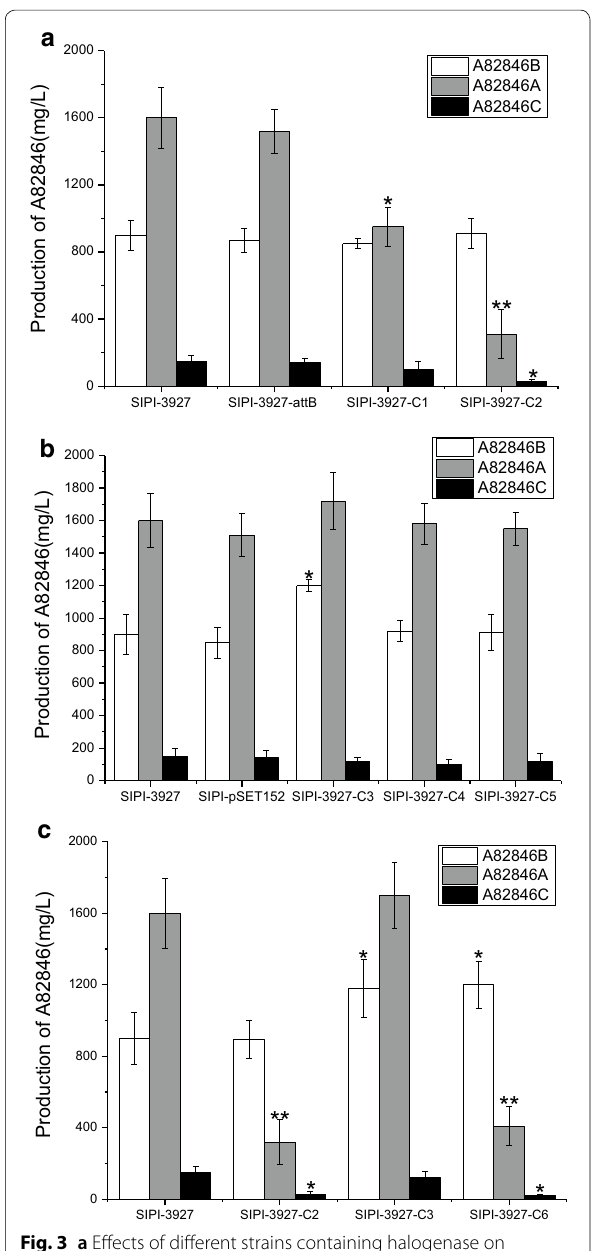
Fig. 3 a Effects of different strains containing halogenase on yield of A82846 analogs. b Effects of different strains containing glycosyltransferase on yield of A82846 analogs. c Comparison of yield of A82846 analogs in control strain, SIPI‑3927‑C2, SIPI‑3927‑C3 and SIPI‑3927‑C6. Different asterisks represent significant differences compared to the parent strain SIPI‑3927 (*P < 0.05; **P <